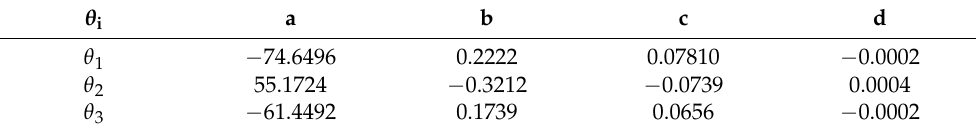
Table 8. The fitting coefficient of θ i .